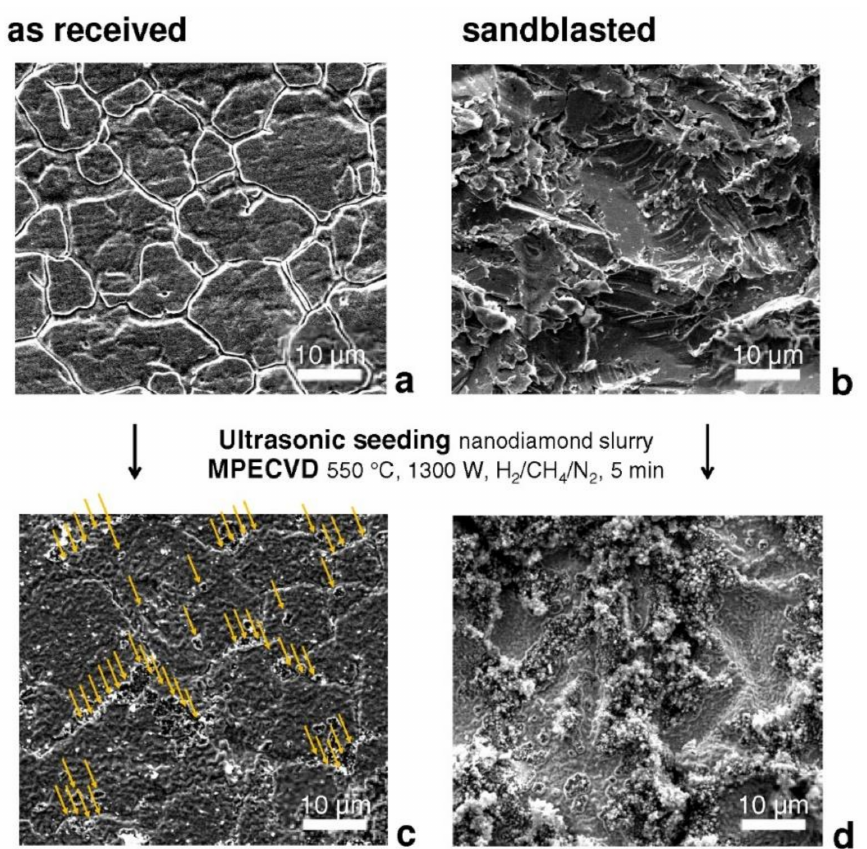
Figure 1. SEM micrographs of the bare SS surface ( a ) as received, ( b ) after surface roughening and ( c , d ) after CVD